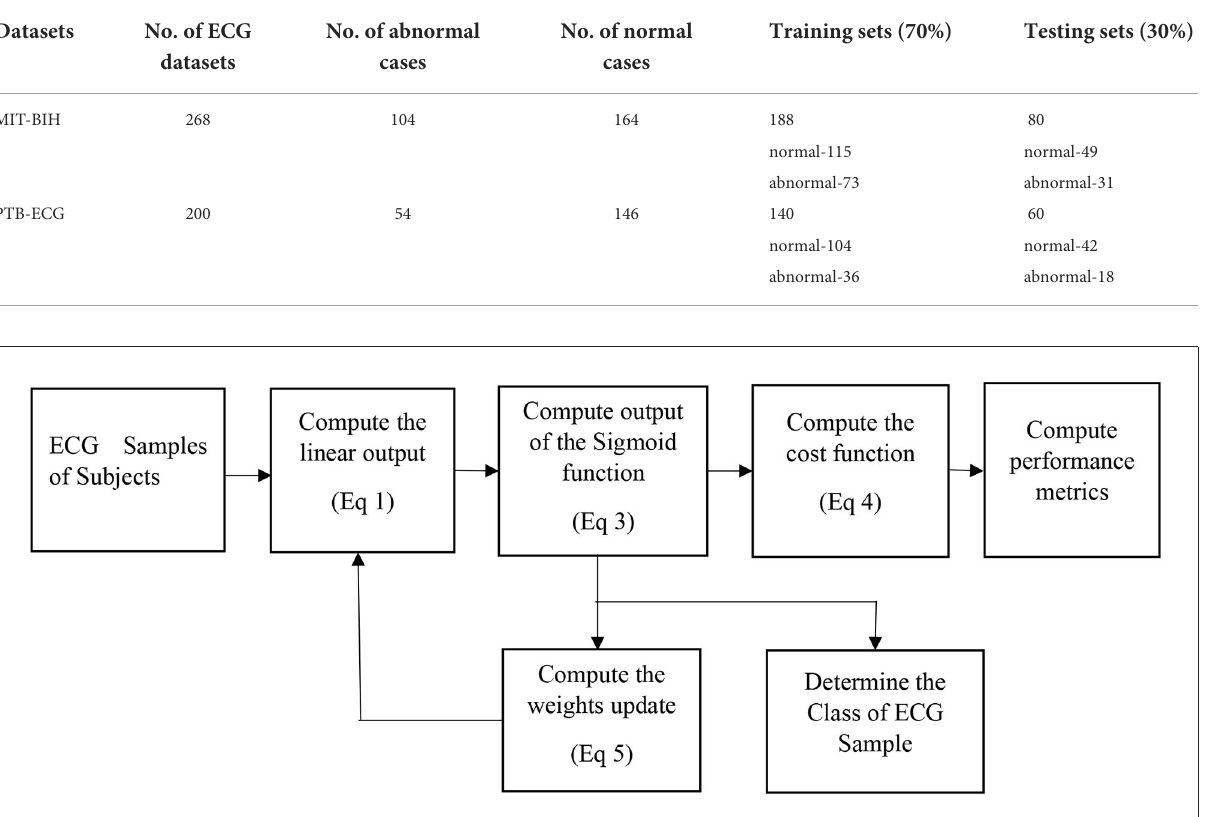
FIGURE1 Block diagram of the logistic regression-based classification model.